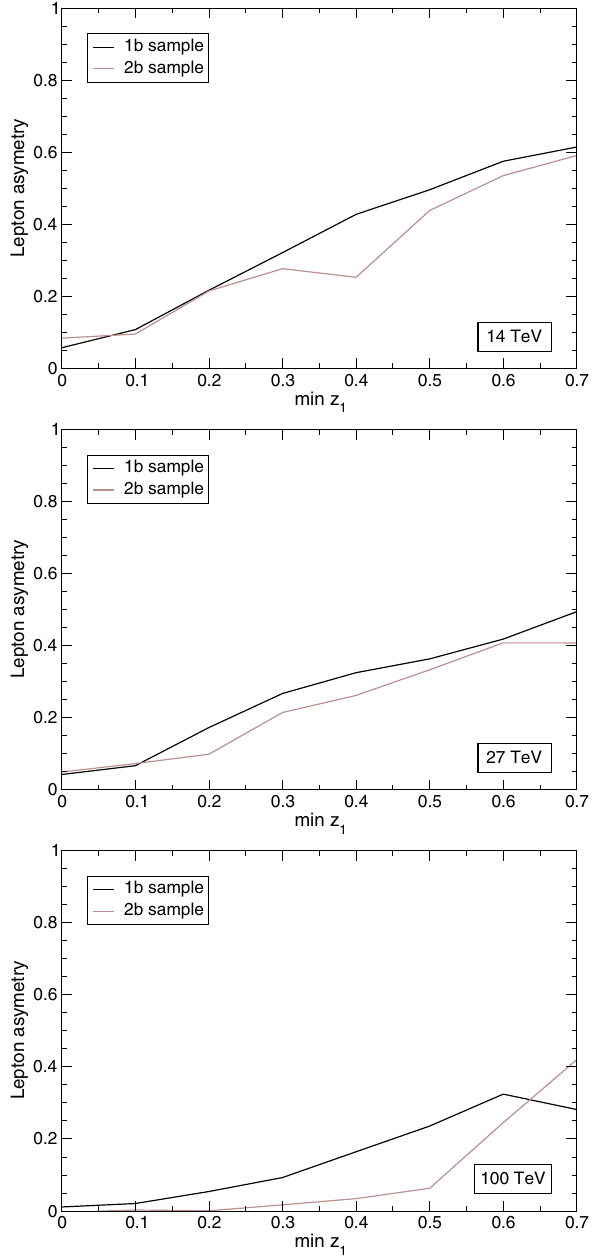
Fig. 9 Lepton charge asymmetry in Eq. (1) as a function of the lower cut on z 1